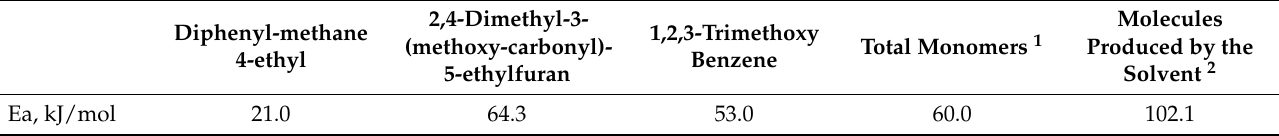
Table 6. Activation energies for the conversion of lignin and solvent to monomers to nongaseous organic compounds.